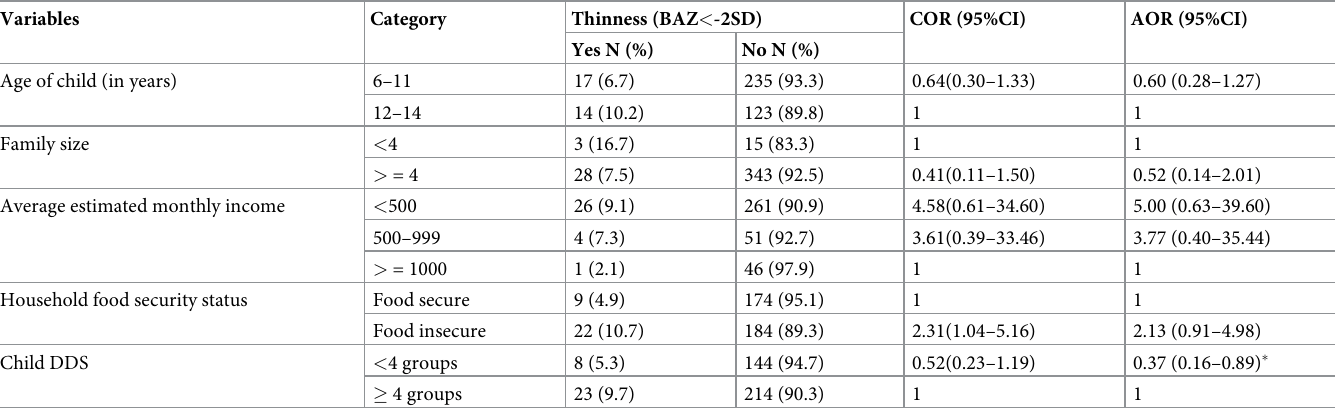
Table 4. Factors associated with thinness among school-age children (n = 391), Arba Minch HDSS, Southern Ethiopia, 2017.